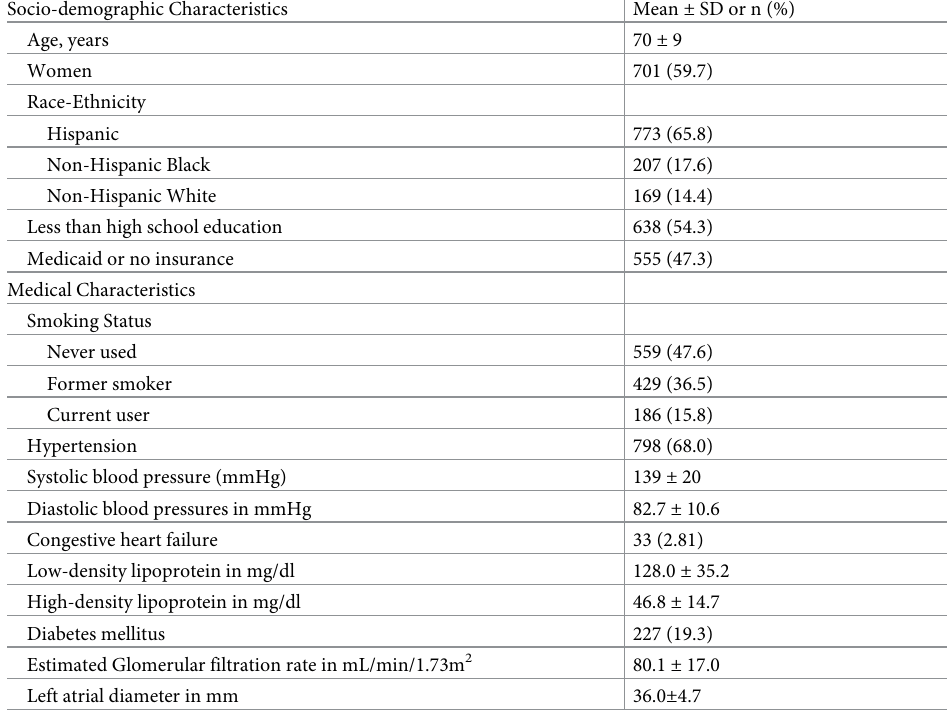
Table 1. Baseline characteristics of the Northern Manhattan Study Magnetic Resonance Imaging cohort (n =